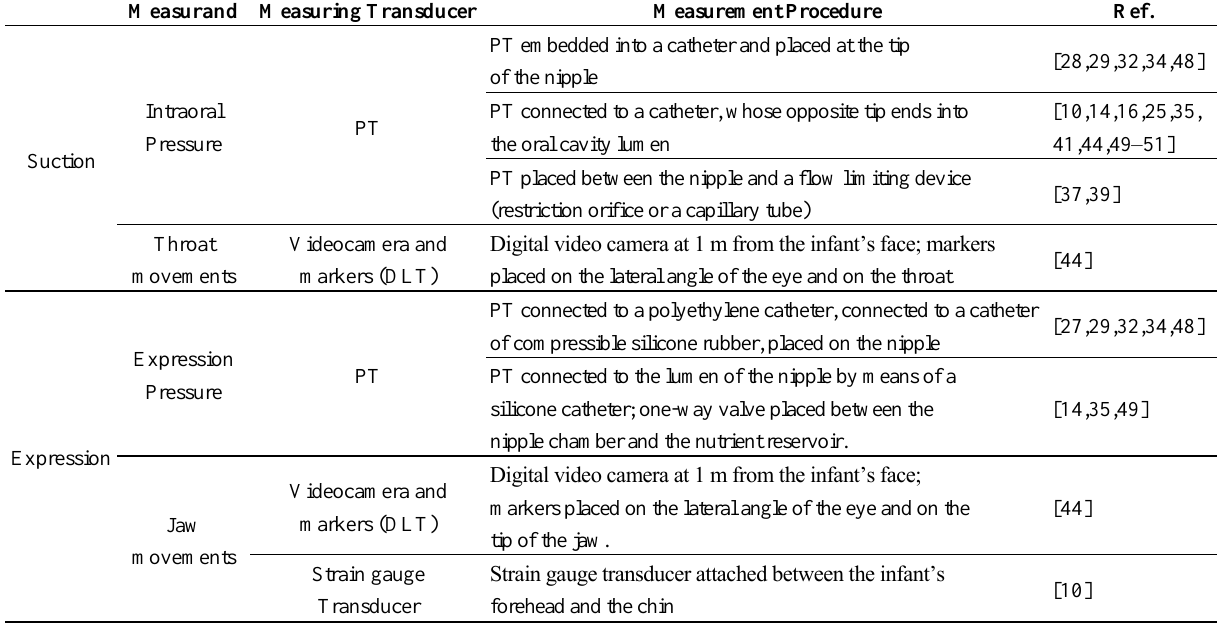
Table 3. Overview of the measuring systems used to monitor sucking process: measurands, sensors and measurement